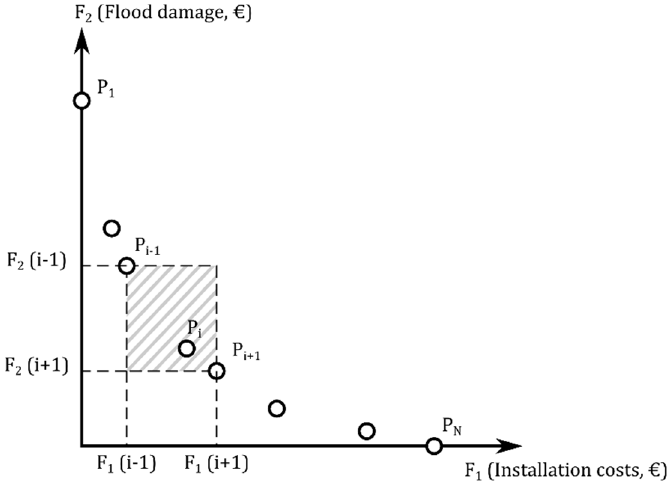
Figure 2. Main features of a Pareto front.